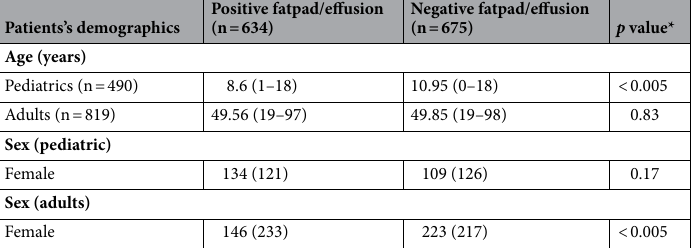
Patients’s demographics